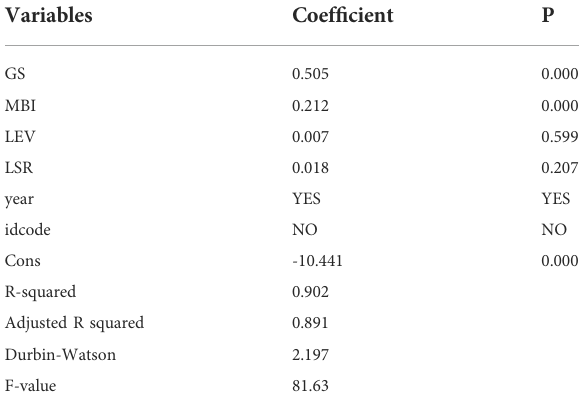
TABLE 9 Generalized Method of Moments results of R&D